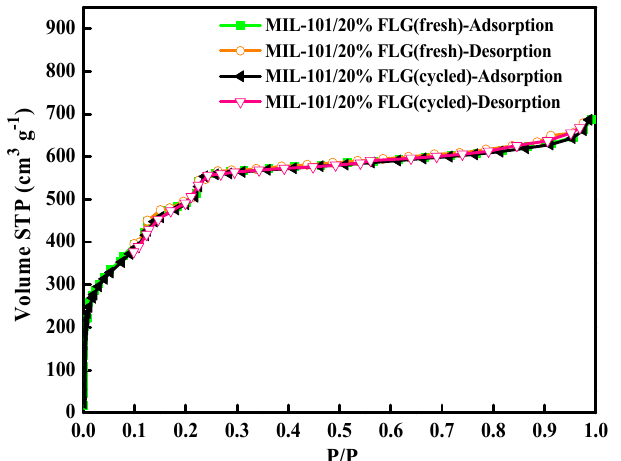
Figure 14. N 2 adsorption/desorption isotherms of fresh MIL-101/20%FLG and cycled MIL-101/20%FLG. Table 2. BET surface areas and pore volume of fresh MIL-101/20%FLG and cycled MIL-101/20%FLG. BET Surface Sample